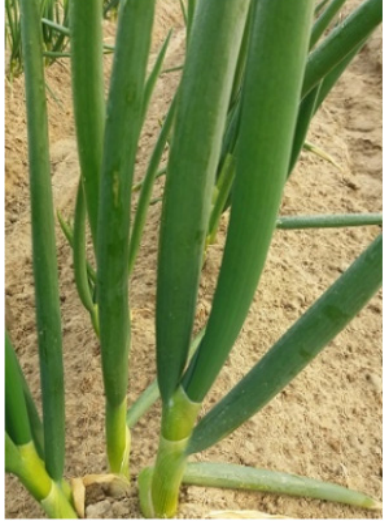
Figure 17. Spring onion without anything detected.